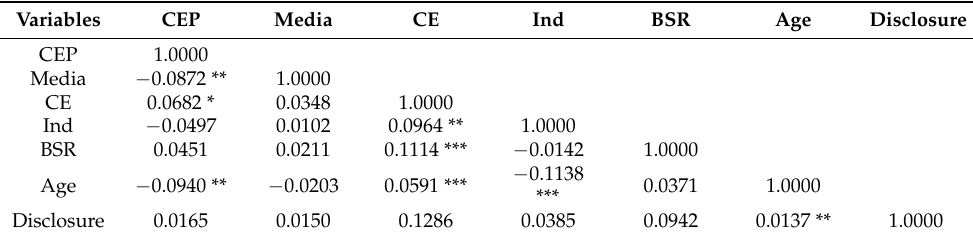
Table 5. Correlation test.